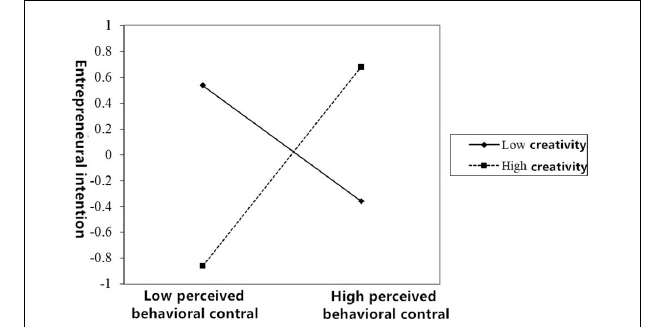
FIGURE 3 | A line chart of the moderating effect of creativity between perceived behavior control and entrepreneurial